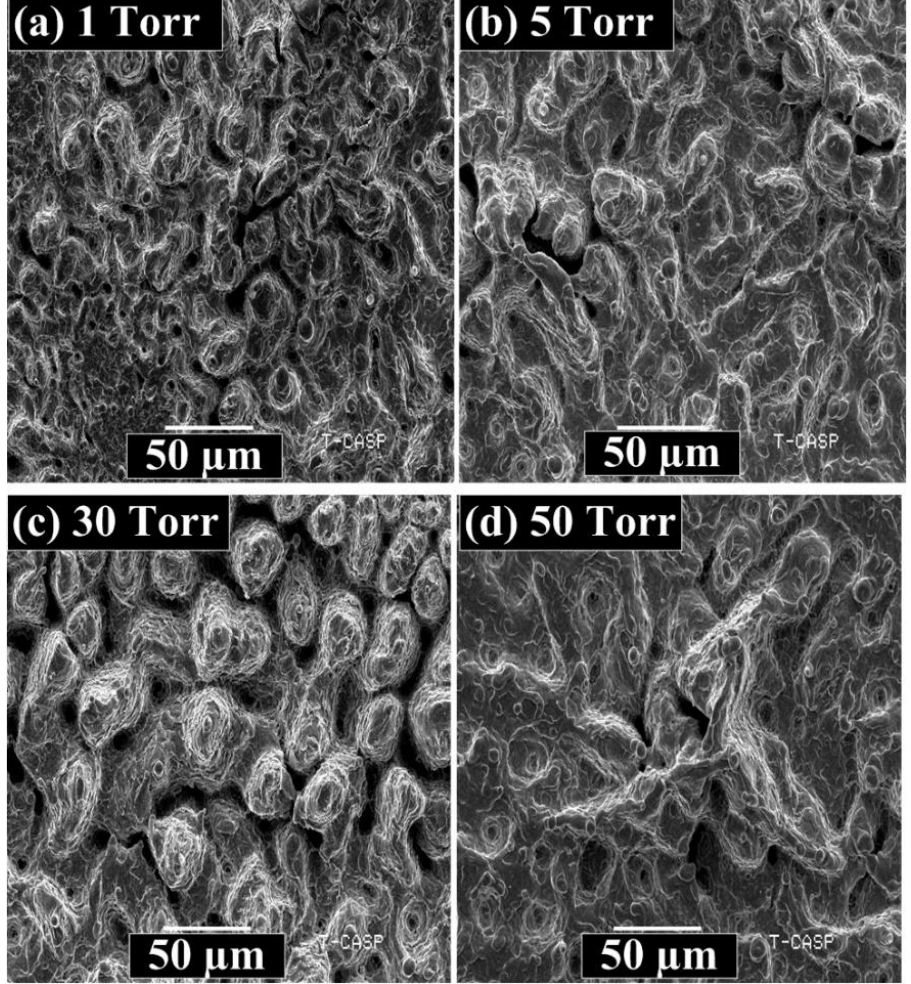
Figure 15. Surface morphological modifications in a He ambient environment at different pressures, ( a ) 1 torr, ( b ) 5 torr, ( c ) 30 torr, and ( d ) 50 torr, with a laser irradiation of 3.8 GW/cm 2 in the TMF.